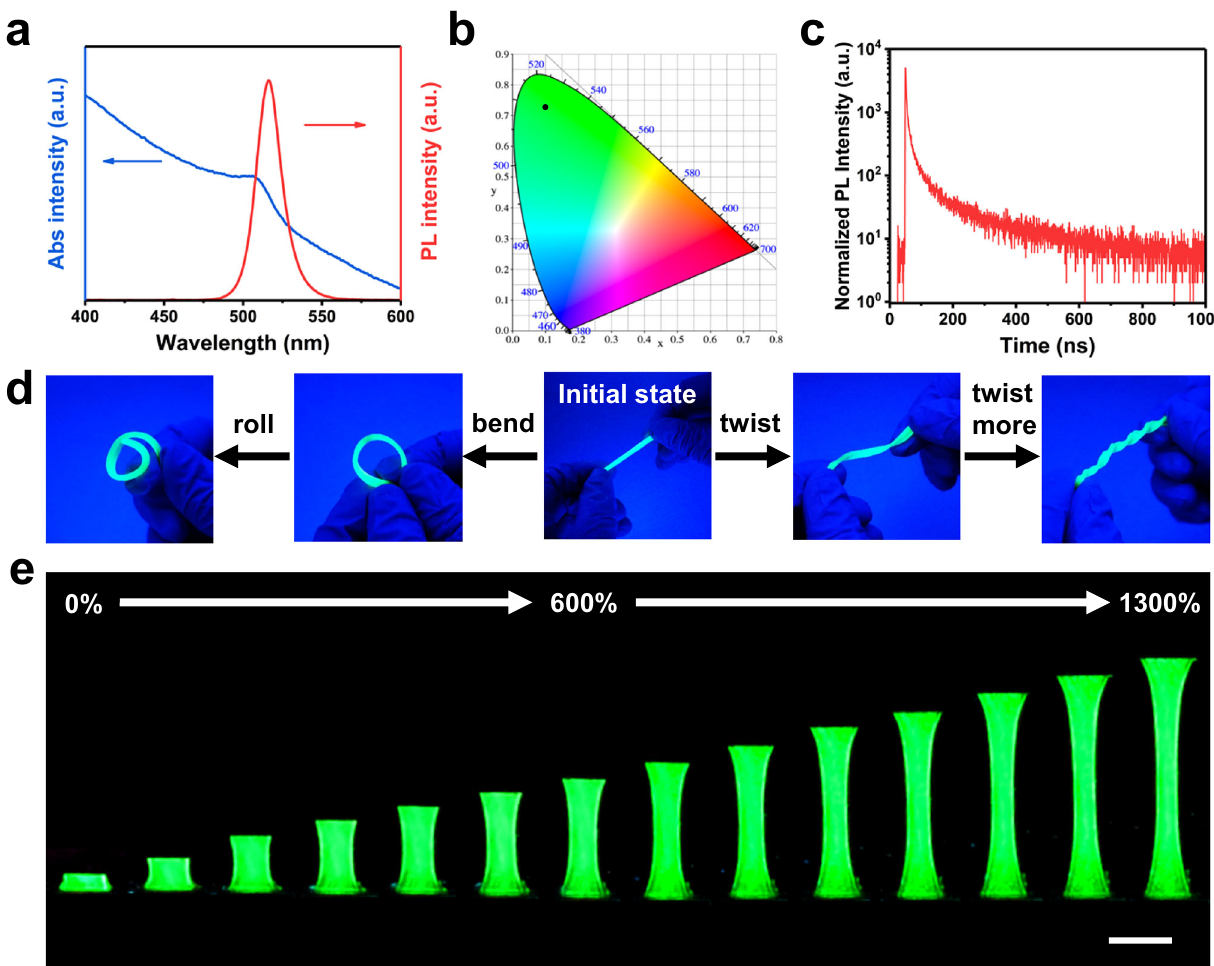
Fig. 4 Optical properties and light-emitting performance of TFE-HF-QD 1.0 . a The UV – vis absorption (blue) and PL emission (red) spectra of TFE-HF- QD 1.0 . b Commission Internationale de L ’ Eclairage (CIE) coordinates for TFE-HF-QD 1.0 . c PL decay dynamics of TFE-HF-QD 1.0 . d Photographs of the light- emitting performance of TFE-HF-QD 1.0 under various deformations: bending, rolling and twisting. e Photographs of the light-emitting performance under strain. Scale bar, 1